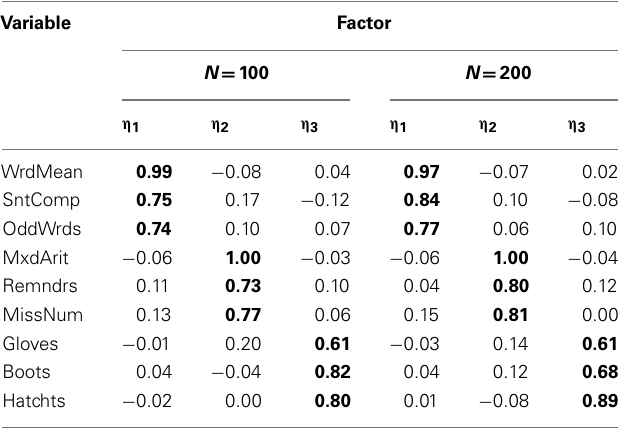
Table 16 |Three-factor model loading matrix obtained with EFA of polychoric R among Case 3 item-level variables.